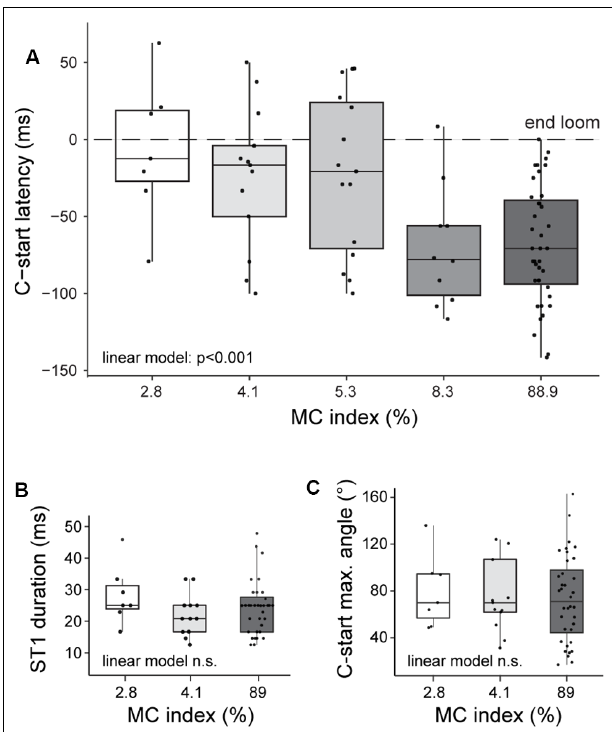
FIGURE 4 | Stimulus saliency is correlated with C-start response latency but does not change its kinematics. (A) Looming stimuli of increasing Michelson index were associated with shorter response latencies (linear model, effect of contrast on latency, p < 0.001). Stage 1 duration (B) or maximum stage 1 angle (C) is similar for IC 2.8 , IC 4.1 , and IC 89 (linear model, effect of contrast on duration, p = 0.77; effect on angle, p = 0.70). Boxplots represent median and 25th and 75th quartiles and minimum and maximum values for each MC. Superimposed dots represent individual